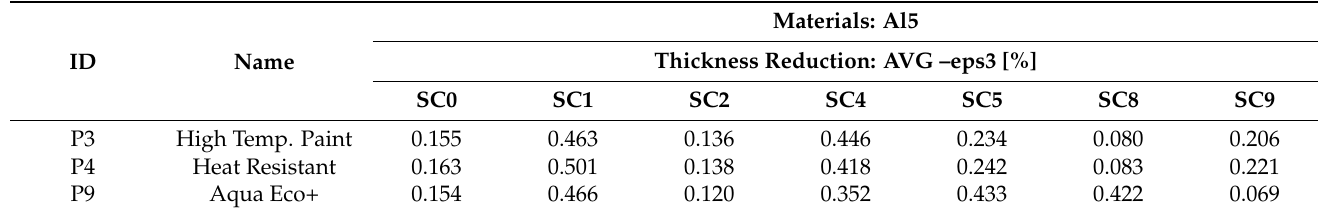
Figure 5. Thickness reduction values for the P9/SC9 sample. To study the performance of the coatings (paintings) further, the thickness reduction values at the peak and their average were collected for each sample. Table 10 provides a summary of these results. Table 10. Thickness reduction results measured at the apex of the test specimen using different painting/cleaning